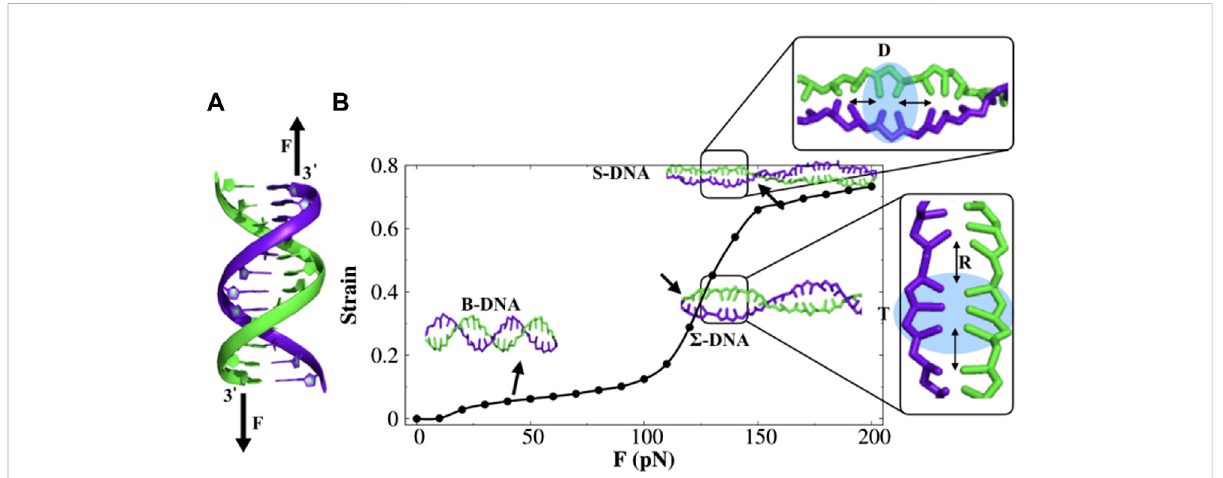
FIGURE 1 Double-stranded DNA (dsDNA) under constant stretching force. (A) Force is applied to the 3 ′ ends of both the strands, shown by black arrows. (B) Force – strain curve of dsDNA. With the increase in force, dsDNA undergoes a structural transition from B-DNA to S-DNA via an intermediate transition,referredtoas Σ -DNA.ThehighlightedregioninboththeS-DNAand Σ -DNAconformationsshowstheappearanceofstackeddoublets(D) and triplets (T) of nucleobases separated by an empty gap of length R . The error bar for each symbol is de fi ned as the standard error. The associated error bars are smaller than the point